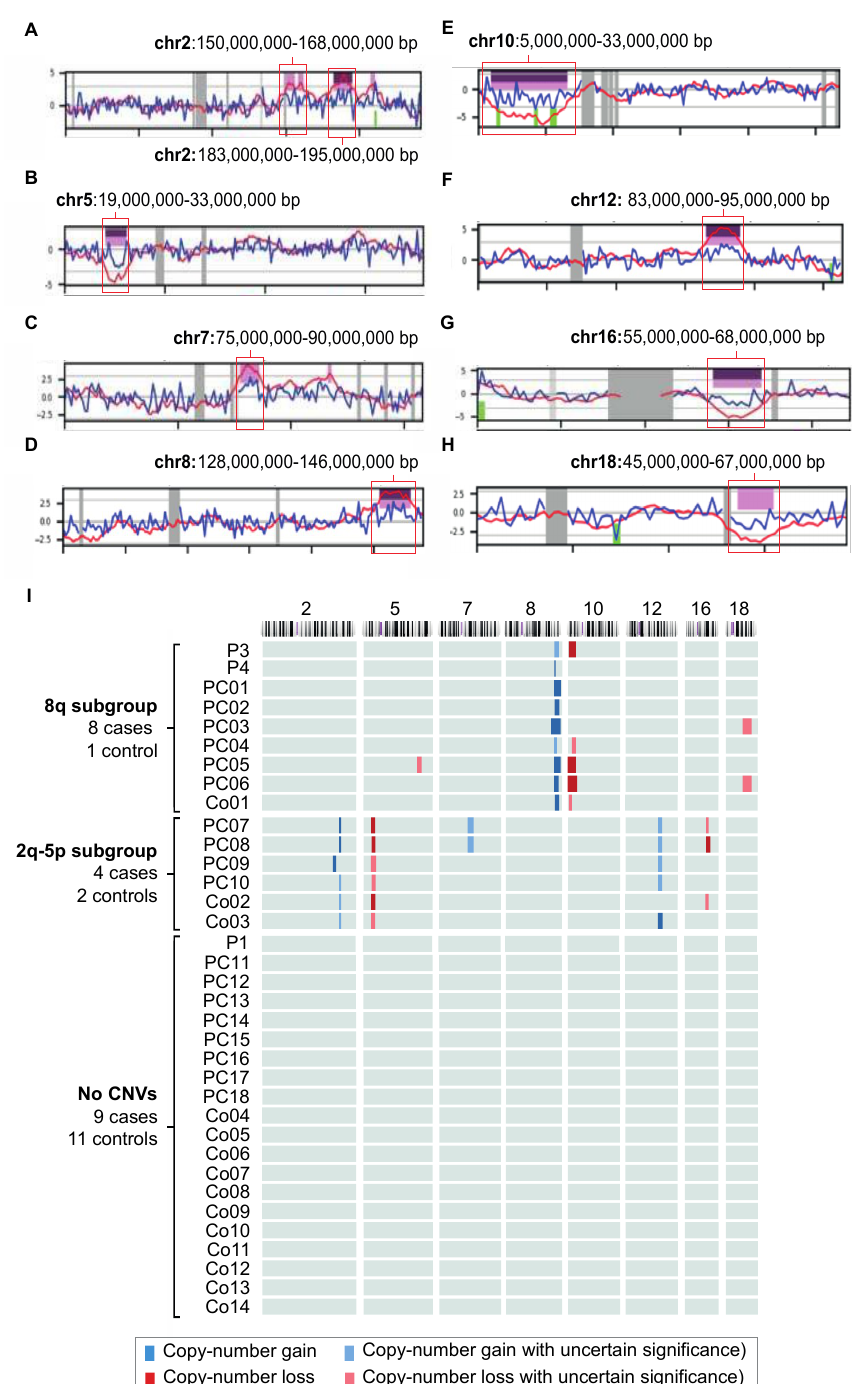
Figure 3. Copy-number gains (blue) and losses (red) per chromosome ( A ) and patient ( B ) of all pancreatic juice (PJ) samples included in the study. ( A – H ). Snapshots of Wisecondor images. Purple = aberration called by software; pink = aberration of uncertain significance. Locations on the chromosomes are given in base pairs (bp). ( I ) Nine individuals had an 8q gain (with or without a 10p loss and/or 18 loss), and six individuals had both a 2q gain and 5p loss (with or without a 7q gain, 12q gain and/or 16q loss). The aberrations in the subgroups did not overlap. P = pilot; PC = PC case; Co = control. Chromosomes without a significant aberration and individuals with a “chaotic profile” (P2, PC19, PC20, Co15 and Co16) are not shown.